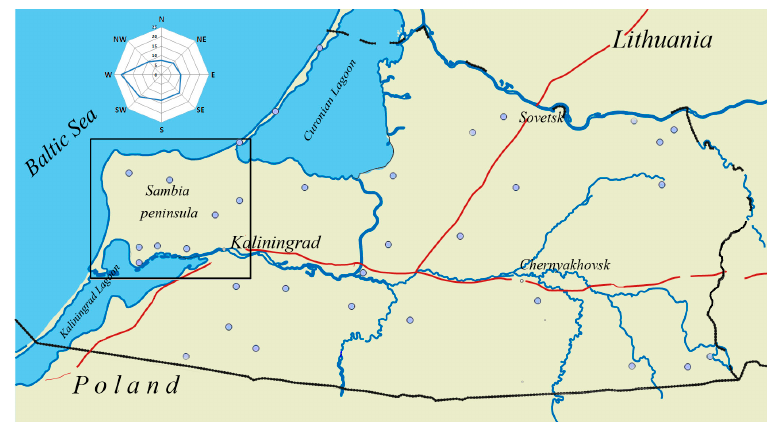
Figure 1. Monitoring grid.